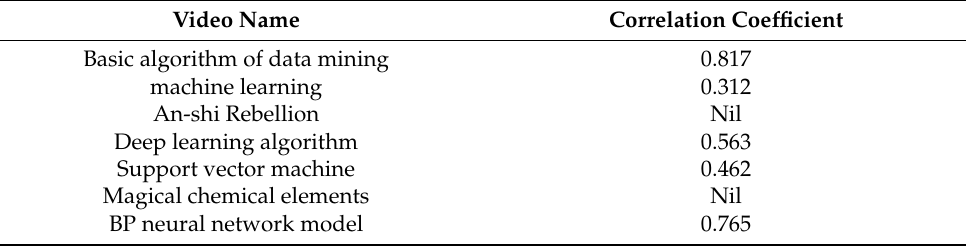
Table 11. Correlation coefficient for